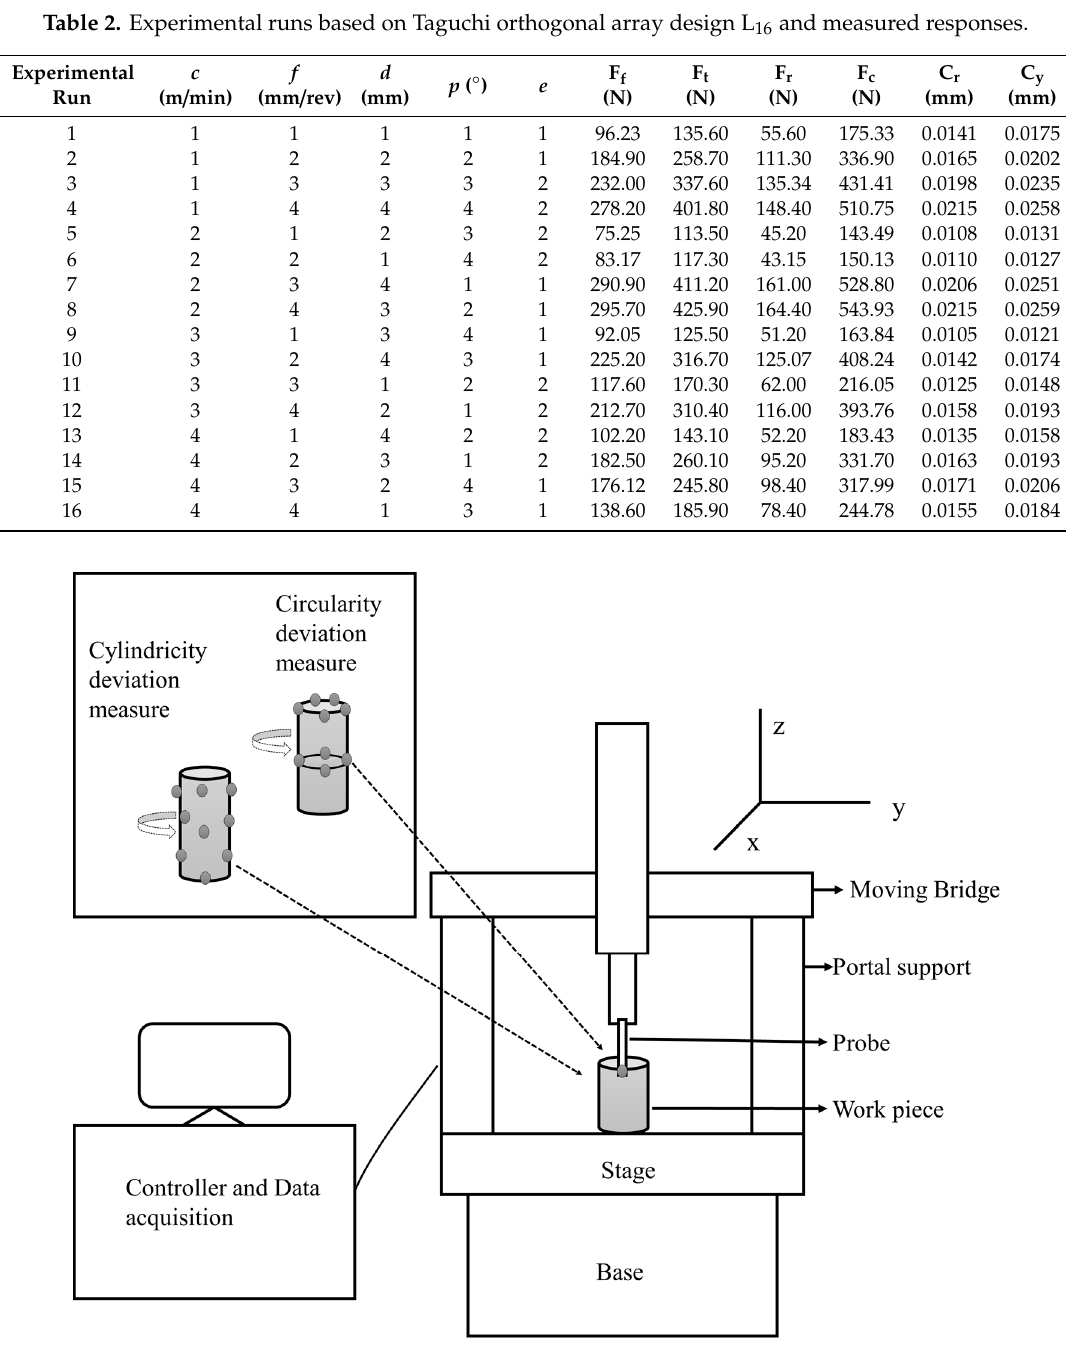
Figure 2. Schematic of a coordinate measuring machine.